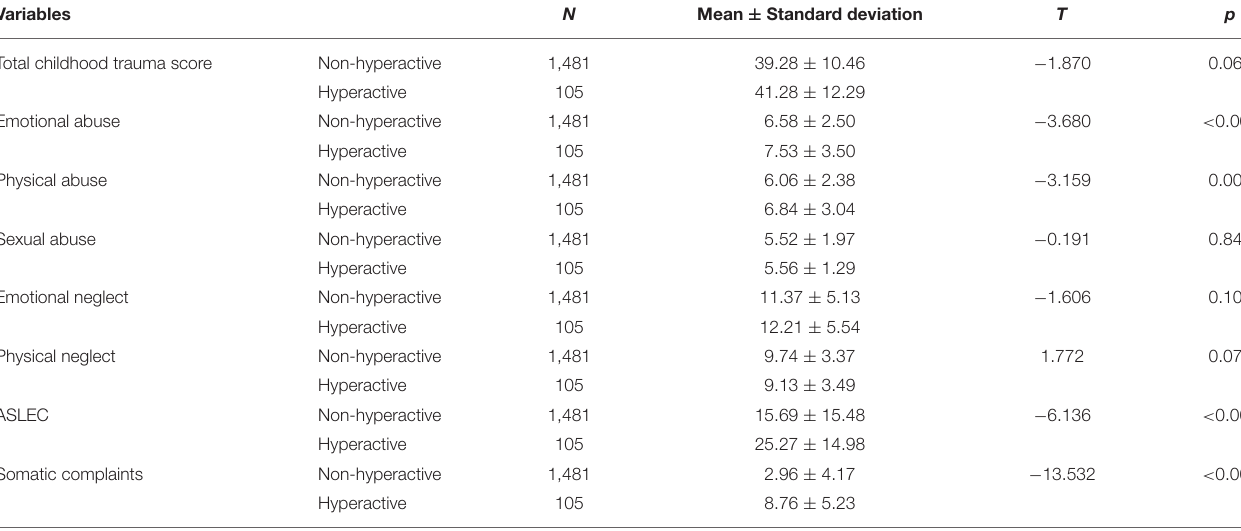
TABLE 1 | Comparison of various childhood abuse scores, total ASLEC score, and somatic complaints between the hyperactive and non-hyperactive groups. Variables